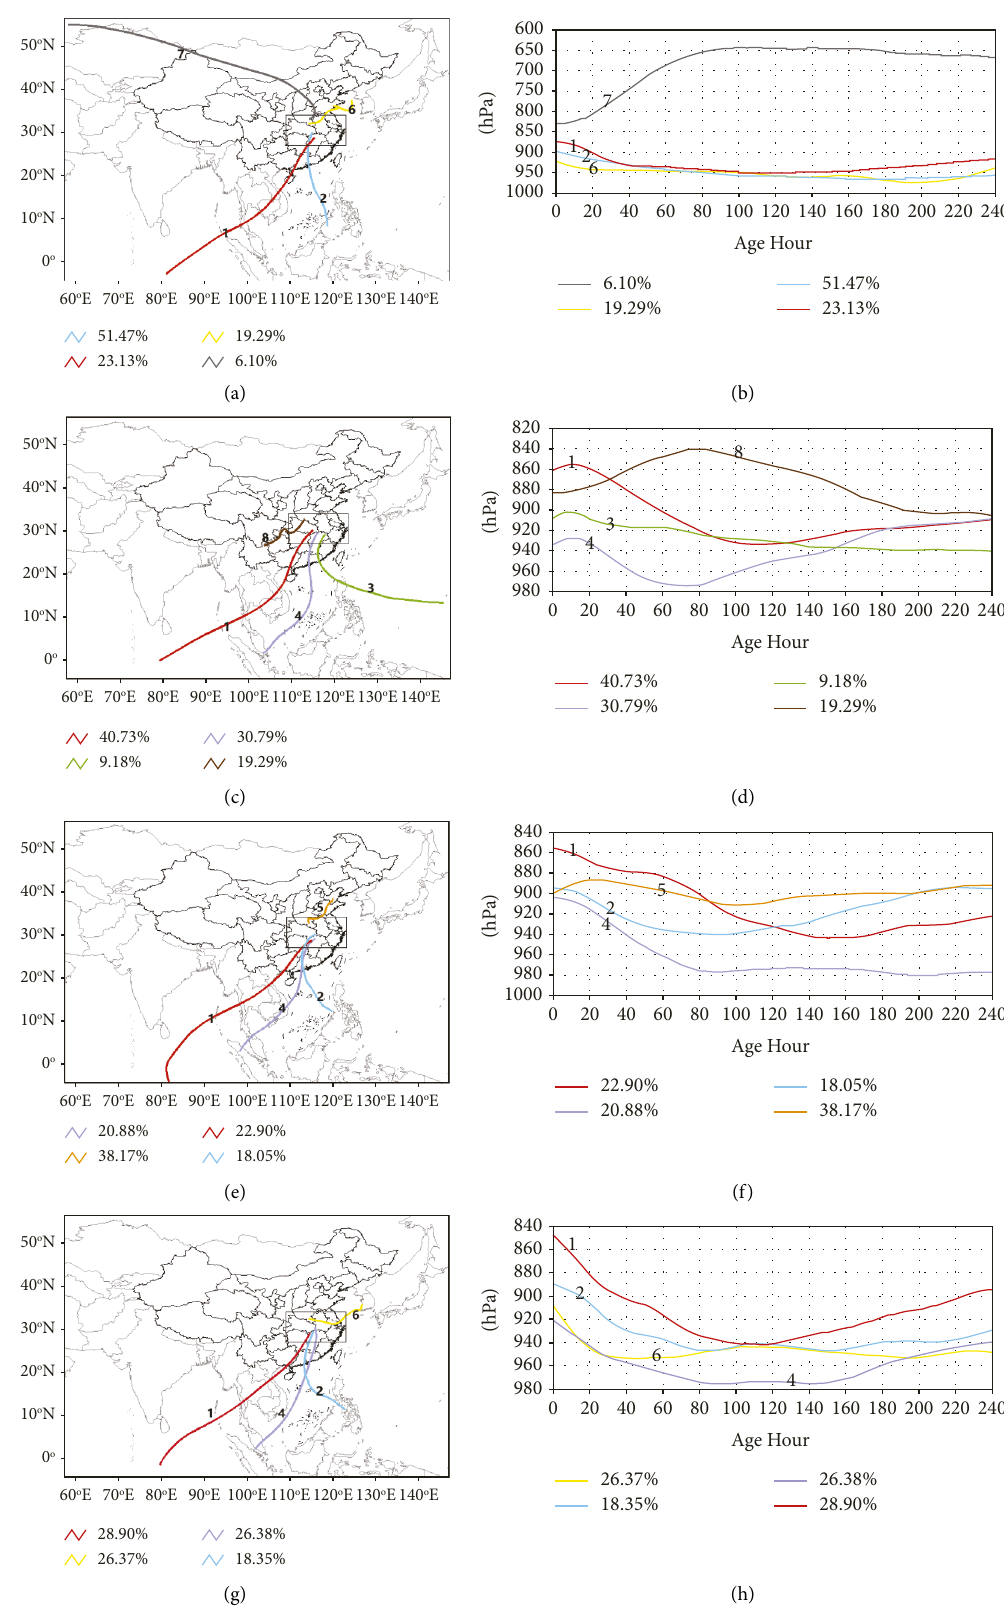
Figure 6: The spatial distribution of lower-level water vapor channels (a, c, e, g) and their height evolution (b, d, f, h) ((a, b) for SFP, (c, d) for SHEP, (e, f) for NCVP, and (g, h) for